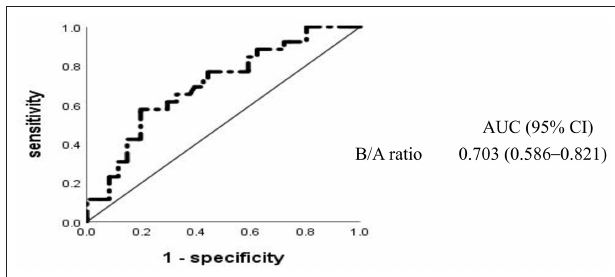
FIGURE 2 | Receiver operating characteristic curves for intravenous immunoglobulin resistance in high-risk Kawasaki disease. AUC, area under the curve; CI, confidence interval; B/A, total bilirubin-to-albumin ratio.